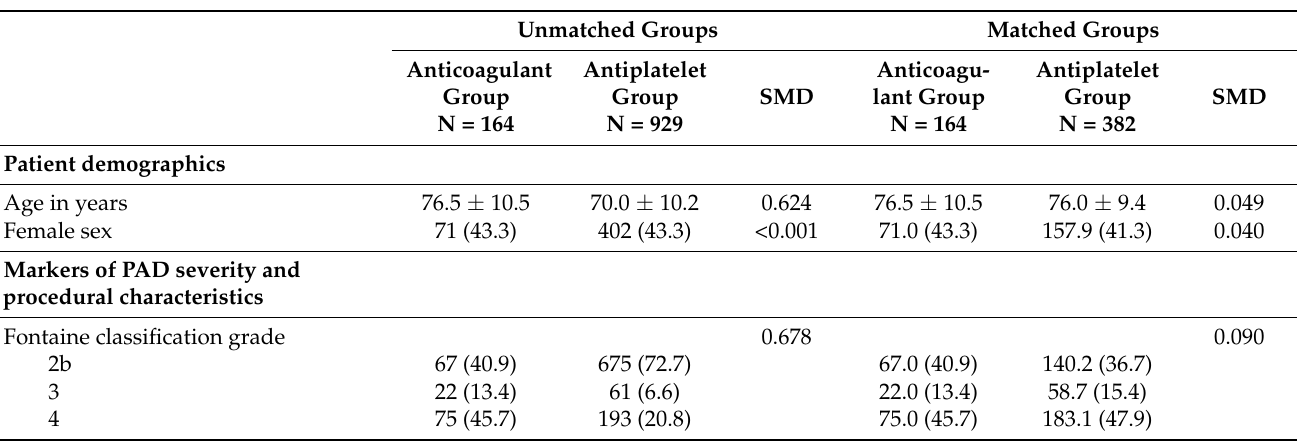
Table 4. Results of propensity score matching with the nearest-neighbour 1:5 algorithm with replace- ment for the group of patients treated with full-dose anticoagulant therapy and the group of patients treated with antiplatelet